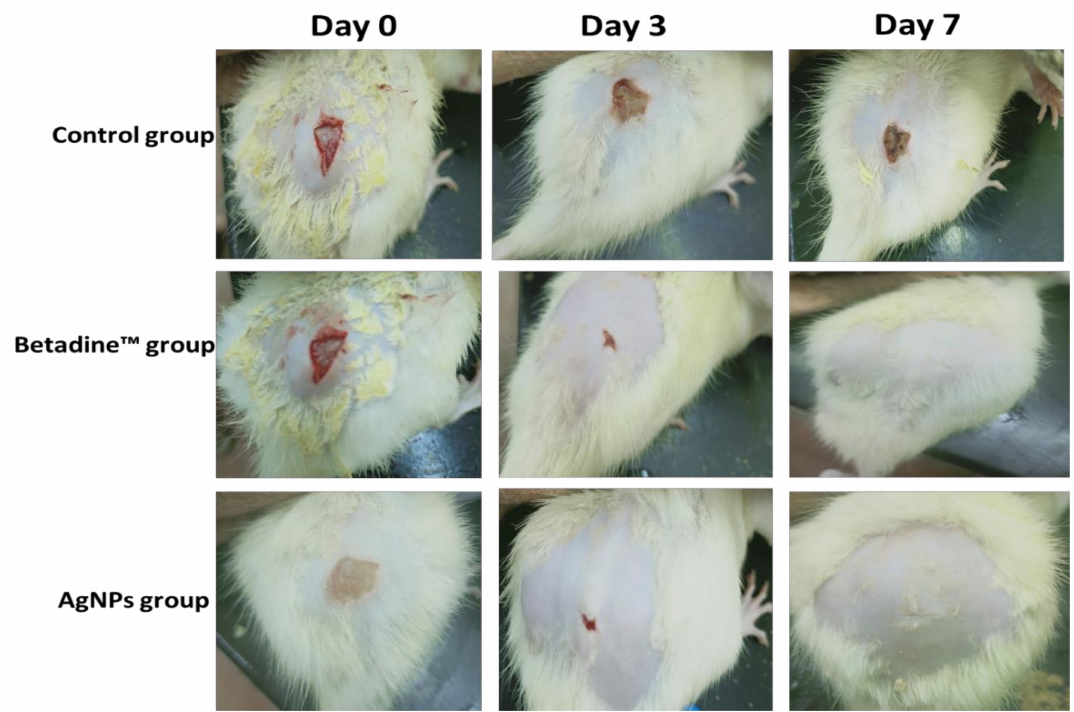
Figure 13. Macroscopic examination of the wound healing of the control, Betadine™, and AgNPs rat groups over the days 0, 3, and 7 starting from the day of wound creation (day 0).